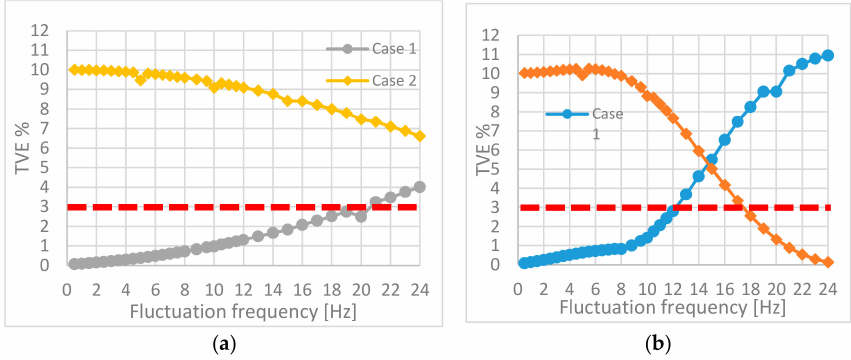
Figure 7. TVE results for PMU B with P ( a ) and M ( b )